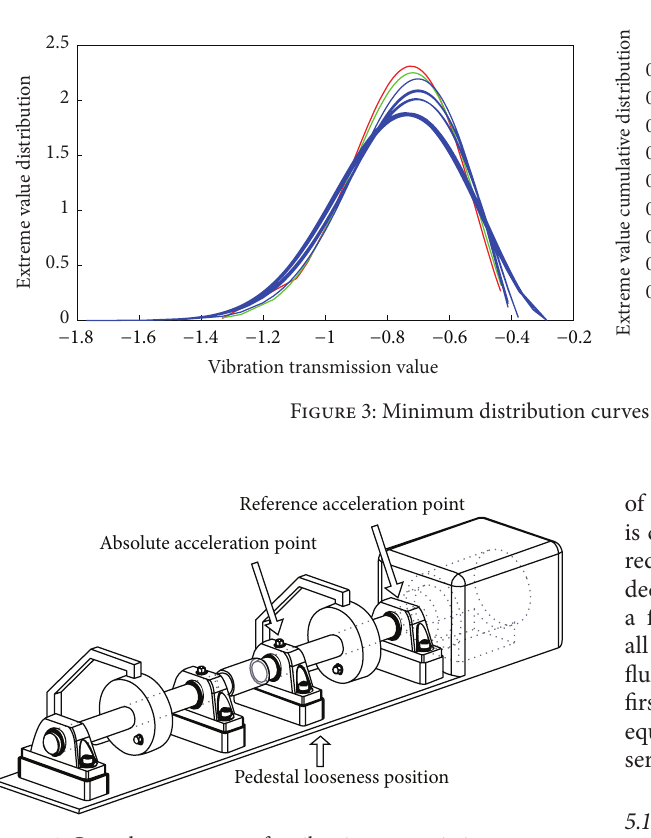
Figure 4: Cascade rotor system for vibration transmission measure- ment with pedestal